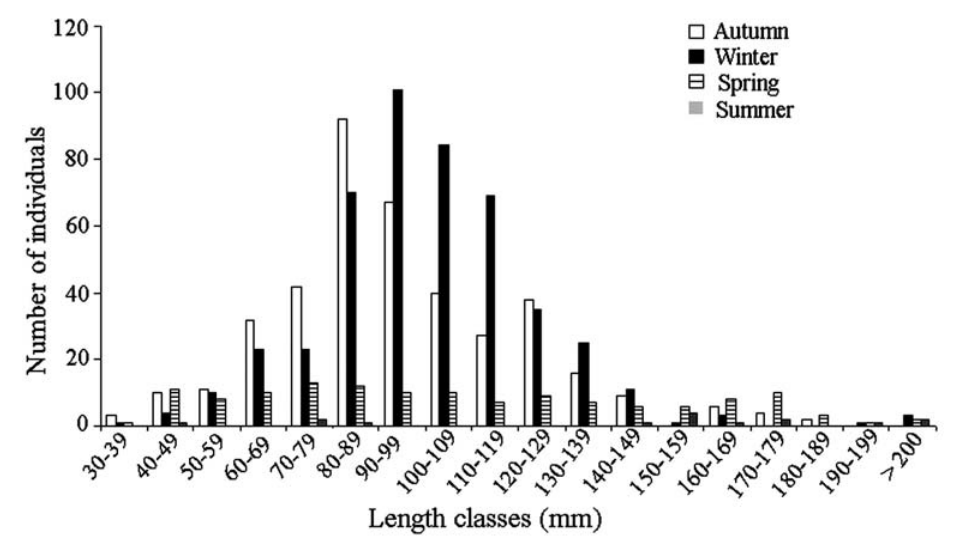
Fig. 4. Number of Isopisthus parvipinnis individuals (n = 990) per length category across those captured along the coast of Ilhéus, Bahia, Brazil.